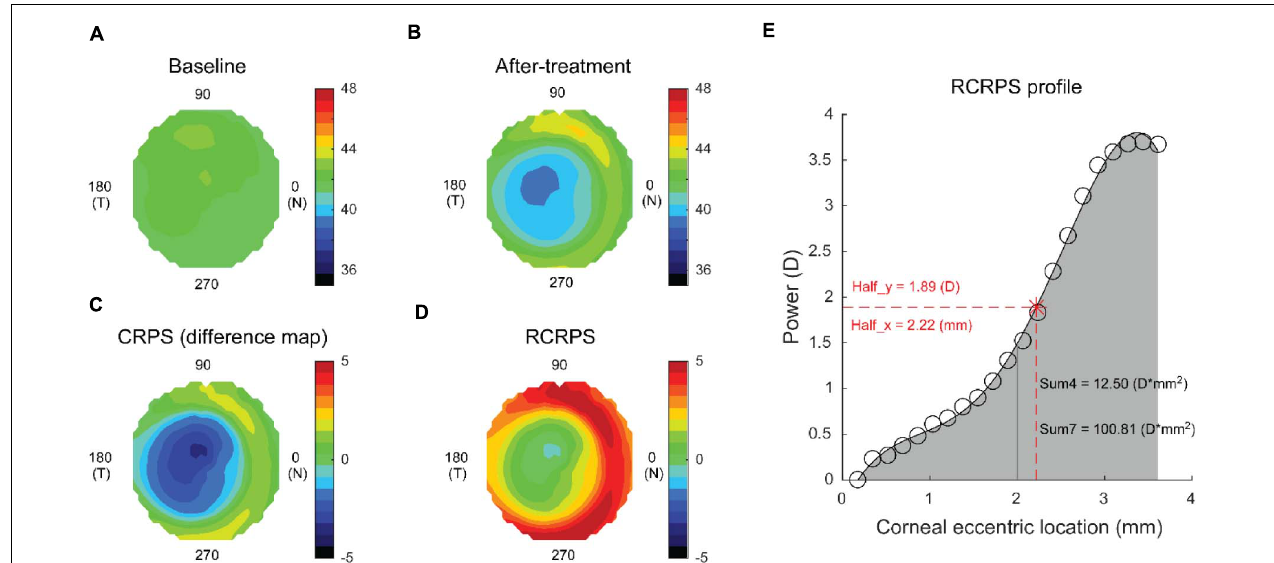
FIGURE 1 | Computation of the RCRPS for a representative eye. (A) An axial map at baseline. (B) An axial map at 12 months after treatment. (C) CRPS was derived by subtracting the baseline map from the after-treatment map. (D) RCRPS was derived by subtracting the center point value from each point on the CRPS. (E) RCRPS profile derived by taking the mean of each ring. Data are for an eye wearing the OK lens. Similar determinations were made for eyes wearing the MFCLs. RCRPS, relative corneal refractive power shift; CRPS, corneal refractive power shift; OK, orthokeratology; MFCL, multifocal soft contact lens; Half_x, the corneal eccentric location where RCRPS reached the half peak value; Half_y, half of the RCRPS peak value; Sum4, the integrated value of the RCRPS located within an area of 4-mm diameter; Sum7, the integrated value of the RCRPS located within an area of 7-mm